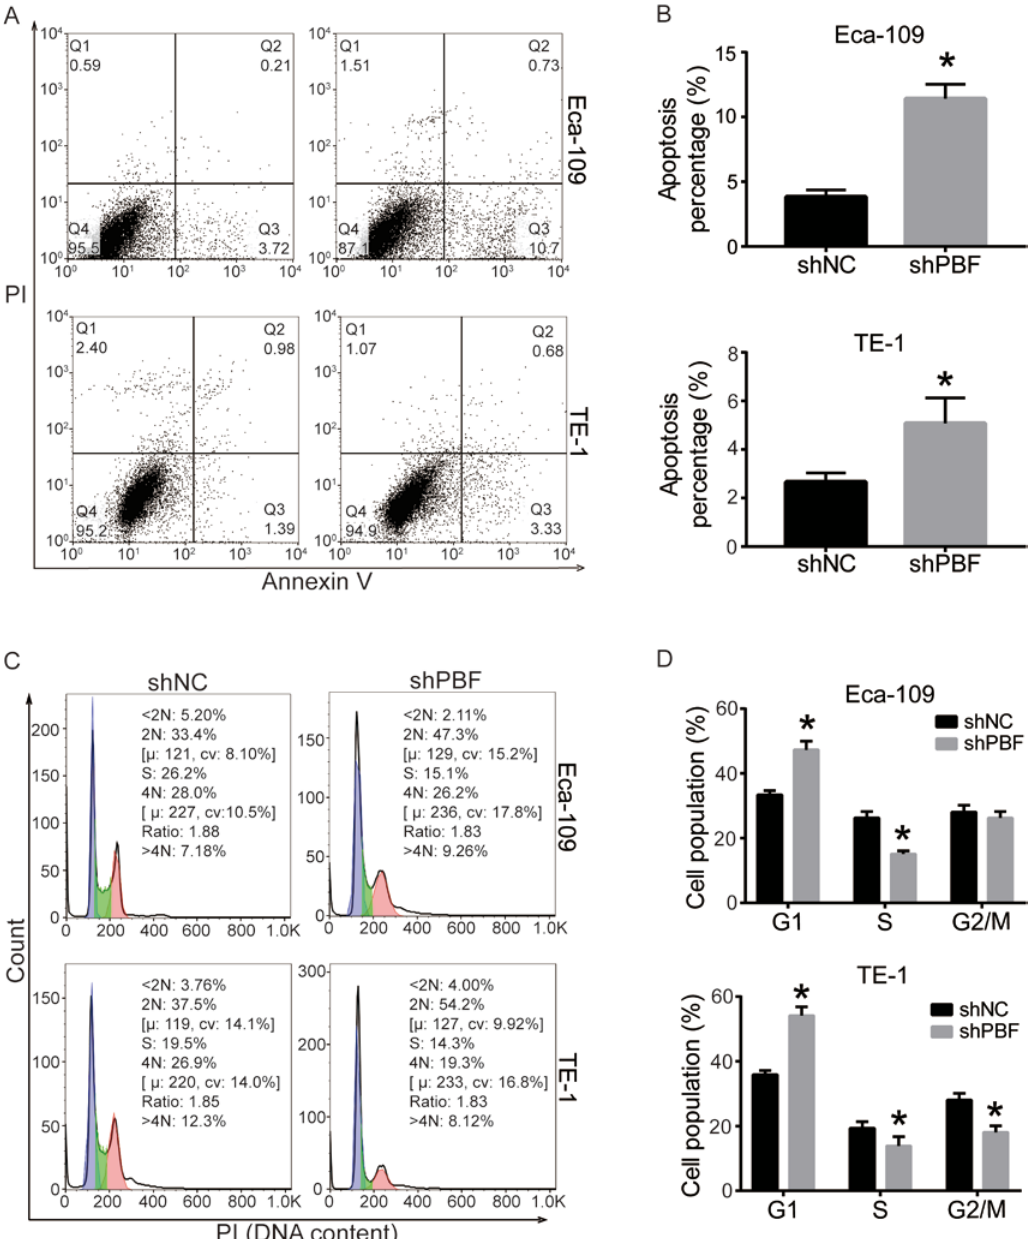
Figure 3: Down-regulation of PBF induces apoptosis and cell cycle arrest in ESCA. Cell apoptosis of Eca-109 and TE-1 was detected by flow cytometry, (A) the histogram of cell distribution after Annexin V/PI stainging, (B) quantitative results of apoptosis percentage. Cell cycle of shNC or sh2-PBF transfected Eca-109 and TE-1 cells was analyzed by PI-staining and flow cytometry, (C) cell distribution in cell cycle, (D) quantitative results of cell cycle distribution. All experiments were repeated 3 times. *P represented significant